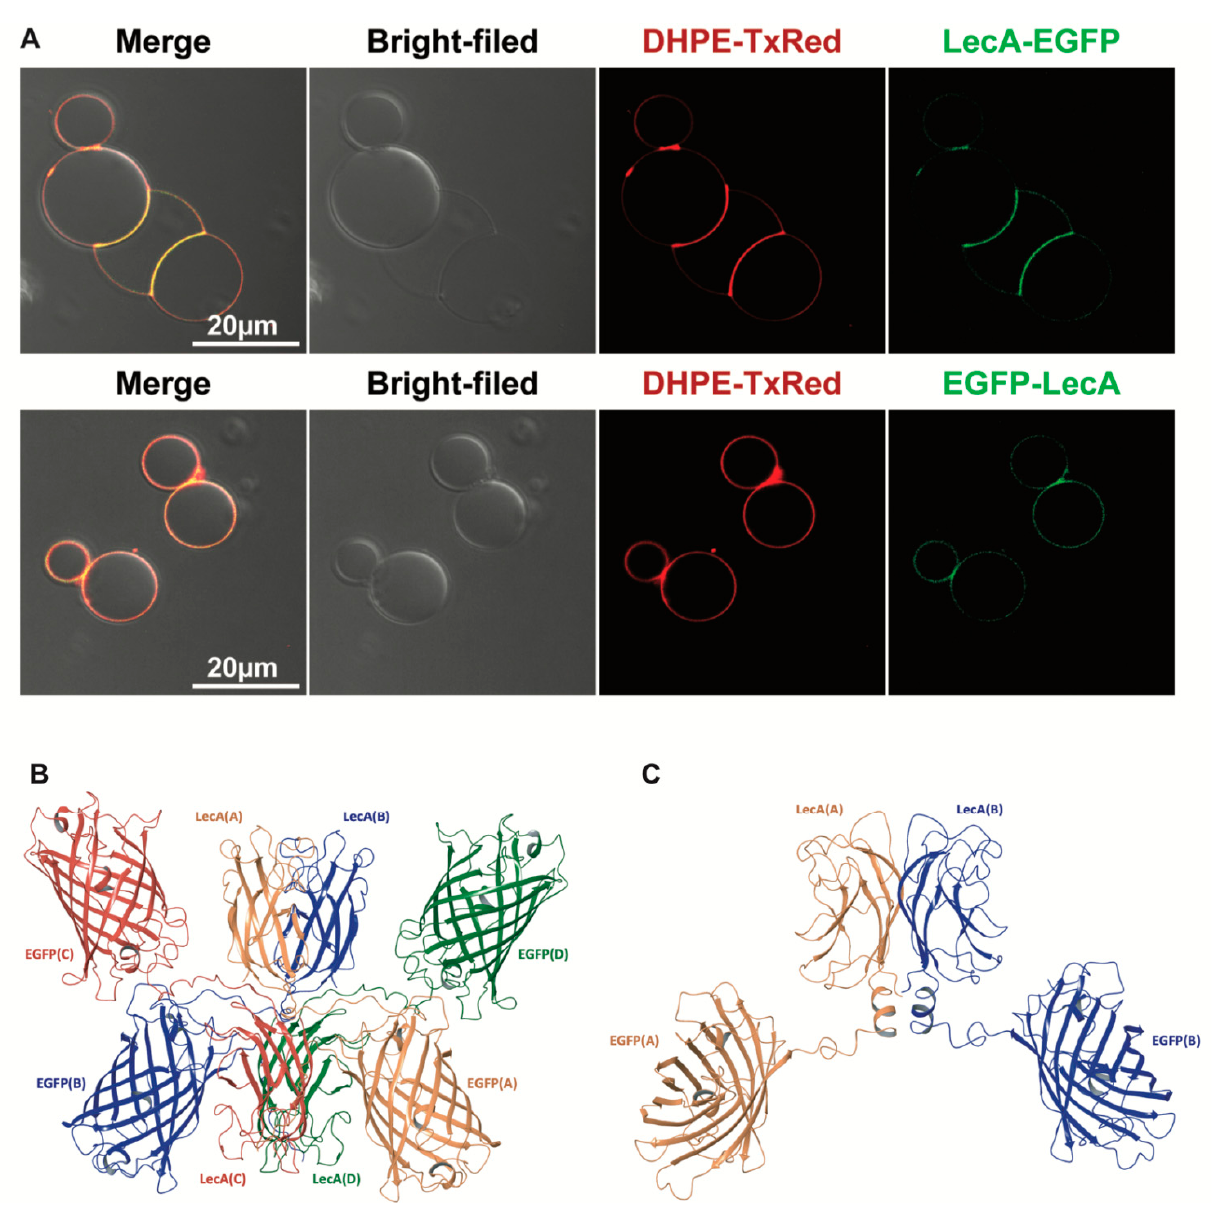
Figure 5. The properties of LecA-fusion proteins. ( A ) LecA-fusion proteins were used to test whether the fusion with EGFP at the N- or C-terminus can block the binding pockets of LecA to the glycosphingolipid Gb3. Gb3-containing GUVs (with Texas Red-labeled 1,2-dihexadecanoyl-sn-glycerol-3-phosphoethanolamine (DHPE-TR) as a fluorescent membrane marker) were separately incubated with LecA-EGFP and EGFP-LecA for 15 min at 37 °C (scale bar: 20 µm). ( B ) The putative structure of LecA-EGFP tetramer fusion protein in a cartoon with each chimeric subunit given in different colors. ( C ) The putative structure of EGFP-LecA dimer fusion protein in a cartoon with secondary structures given in different colors.